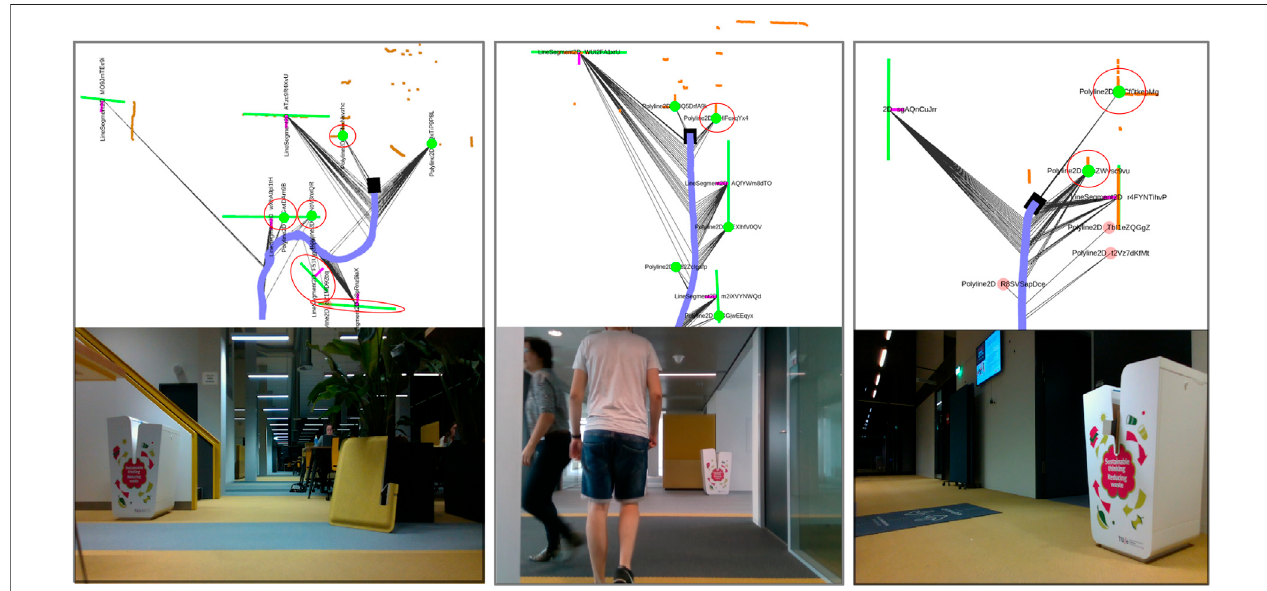
FIGURE 13 | Three situations in which the local map contains objects that are not on the global map (marked by red circles). The camera images from the robot ’ s camera have been logged for veri fi cation purposes. The fi rst situation is scenario C12 where disturbances have been added on purpose. The second scenario is B5 wherethesceneisdisturbedbypedestrianswalkinginfrontoftherobot.ThethirdscenarioisB10,wheretherobotleavesaroomandspotsadustbinandanopendoor as corner features. Both are not on the global map and require suf fi cient not-on-map assumptions to survive the pruning process.